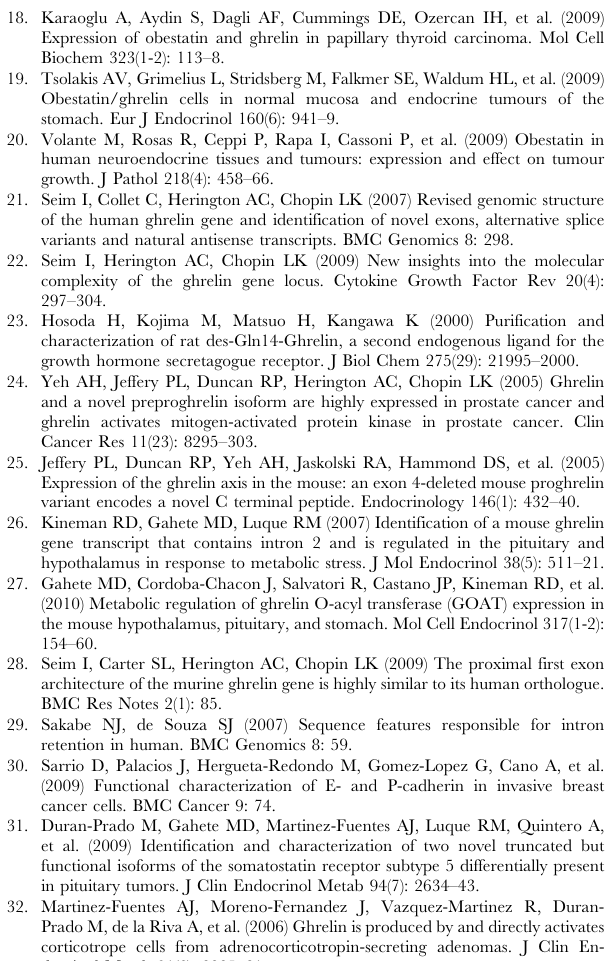
Table S1 Primers used to identify and clone human In1- ghrelin isoform. Table S2 Sequences and product sizes of primers used in qrt-PCR. Table S3 Absolute mRNA copy number of ghrelin axis components in human tissues included in the commer- cial panel of total RNA from Clontech. Table S4 Expression level of ghrelin axis in breast tissues and cell